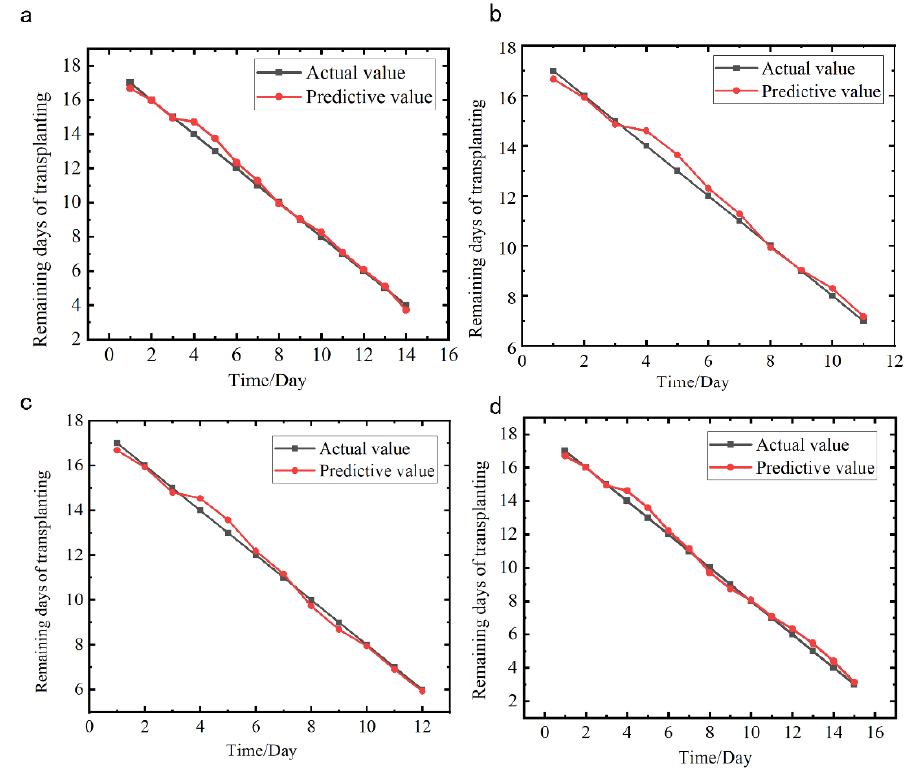
Figure 6. Prediction results of transplanting time for four samples in the test set. ( a ) Test sampling plants 5, ( b ) test sampling plants 10, ( c ) test sampling plants 15, ( d ) test sampling plants 20. The horizontal axis represents the time of seedling growth, and the vertical axis represents the remaining transplanting time. The black rectangles represent the true values, and the red dots represent the predicted values.